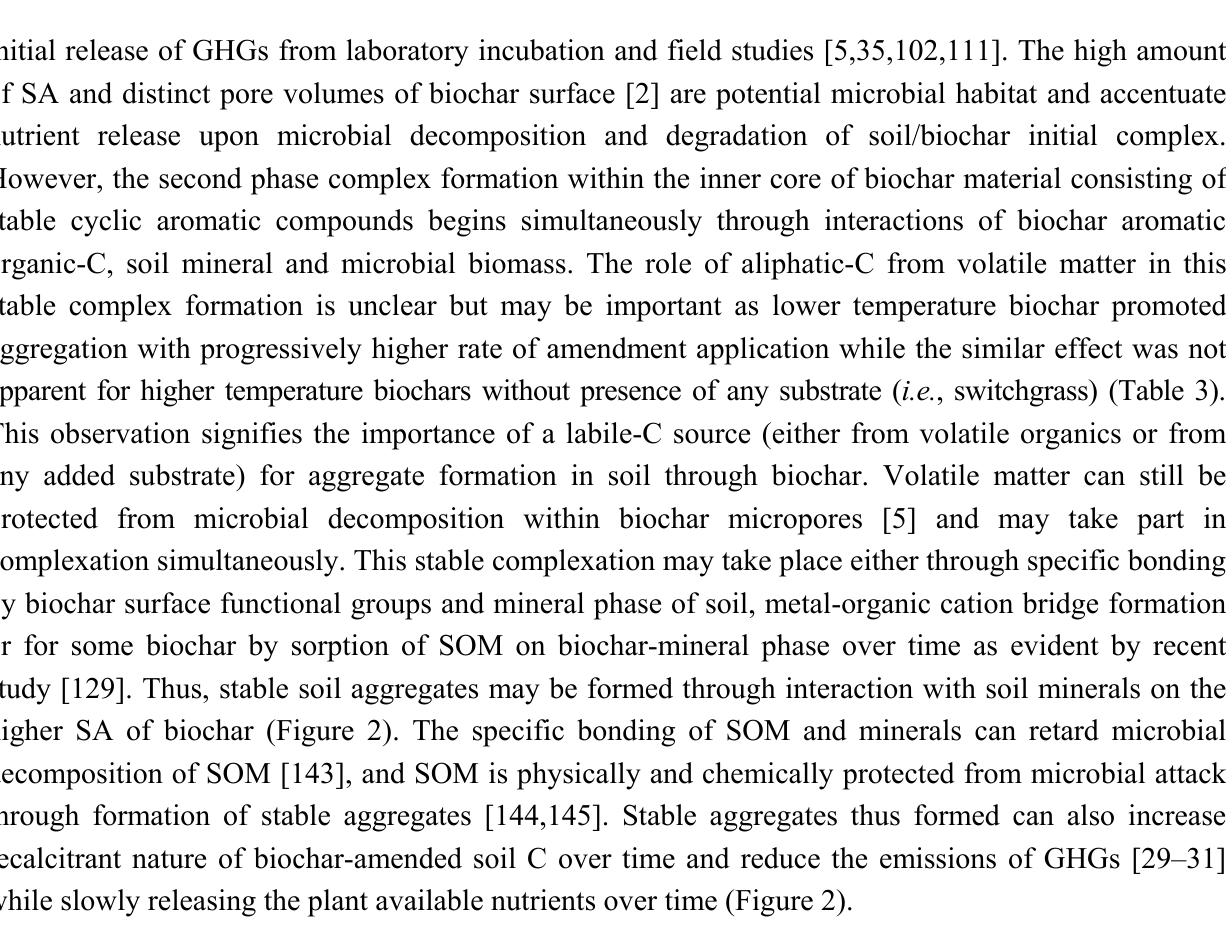
Figure 1. Schematic representation of interactions between biochar and